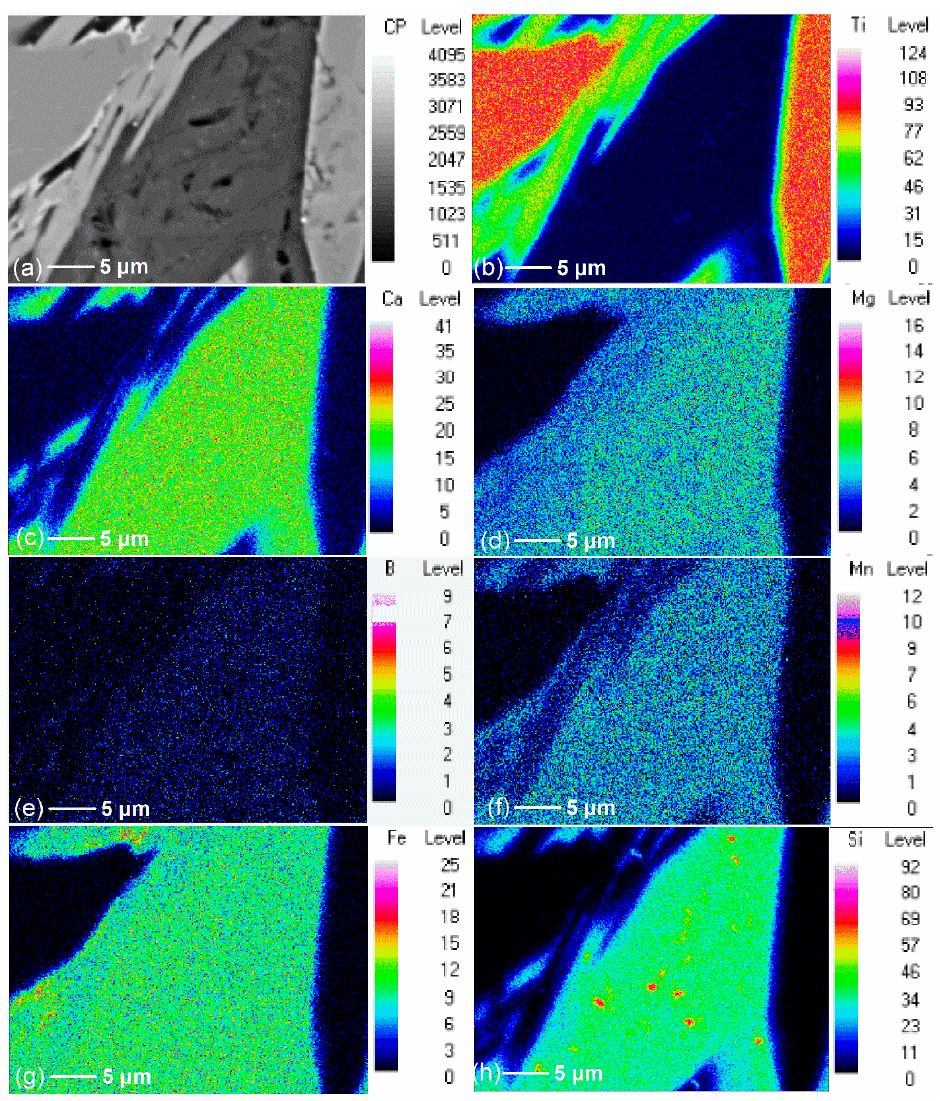
Figure 6. WDS mapping analysis of the cross-section of block sample of the modified titanium slag with the additive (B 2 O 3 ) amount of 6%: ( a ) total, ( b ) Ti, ( c ) Ca, ( d ) Mg, ( e ) B, ( f ) Mn, ( g ) Fe, and ( h ) Si.